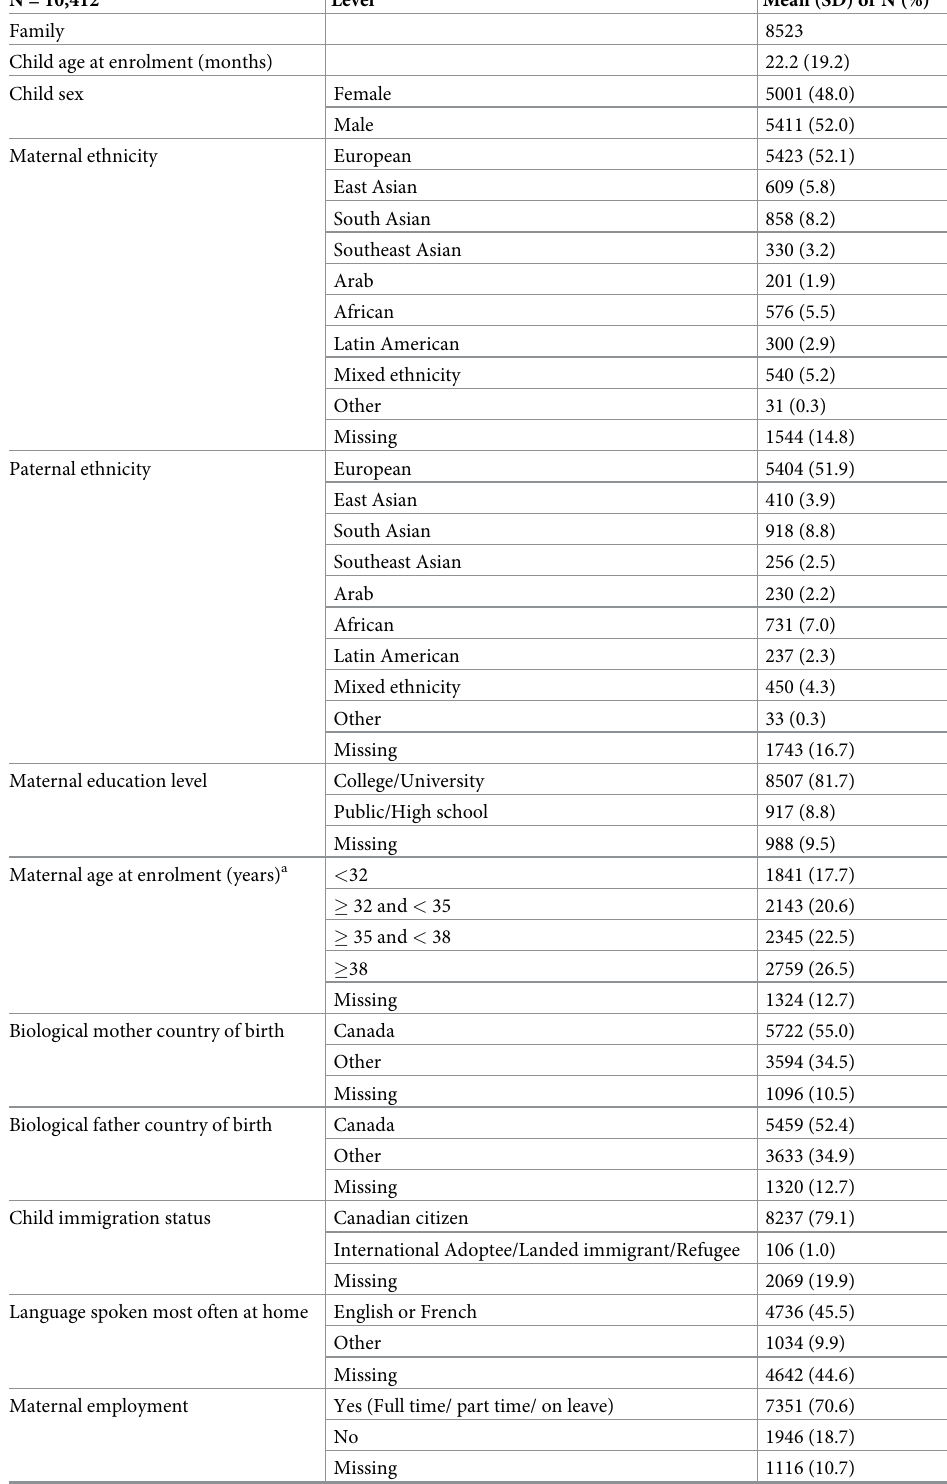
Table 1. Non-time-varying characteristics at